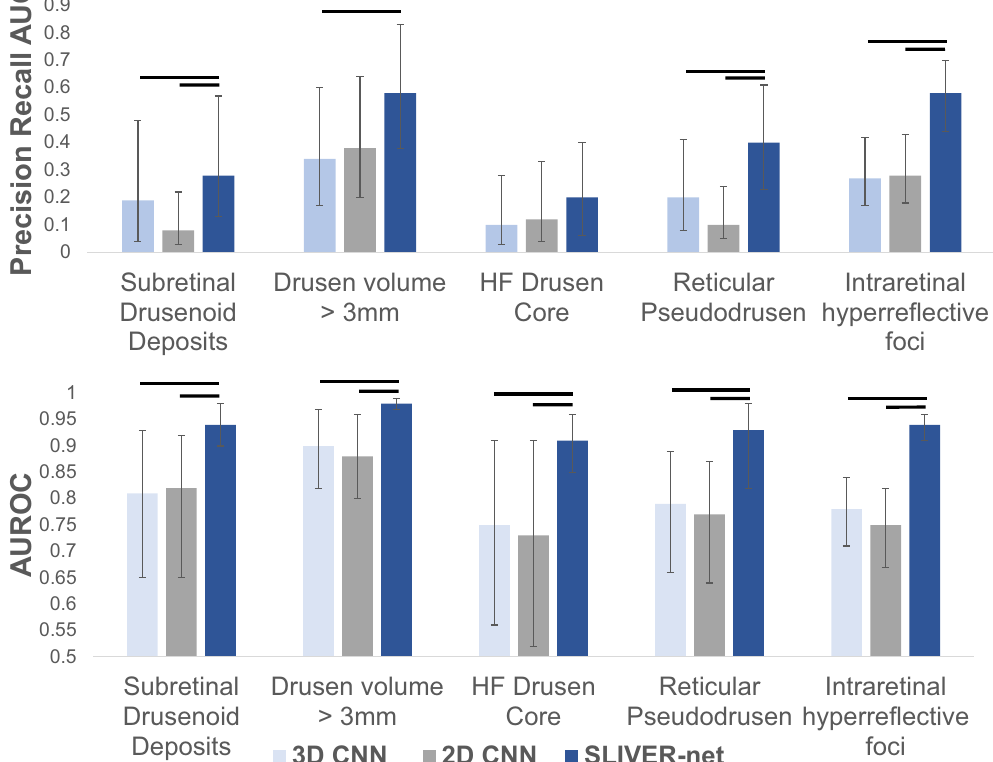
Fig. 1 SLIVER-net performance. SLIVER-net (dark blue) was compared with a 3D-CNN backbone approach (light blue) and 2D CNN (gray). SLIVER-net signi fi cantly outperformed both the 3D CNN and 2D CNN in identifying each biomarker in terms of area under the ROC (AUROC) and area under the precision-recall curve (precision-recall AUC). Top: Precision-recall AUC for each biomarker. Bottom: ROC AUC for each biomarker. Horizontal bars indicate a signi fi cant difference in performance between the two models. Error bars represent 95% con fi dence interval (CI) calculated using a bootstrapping